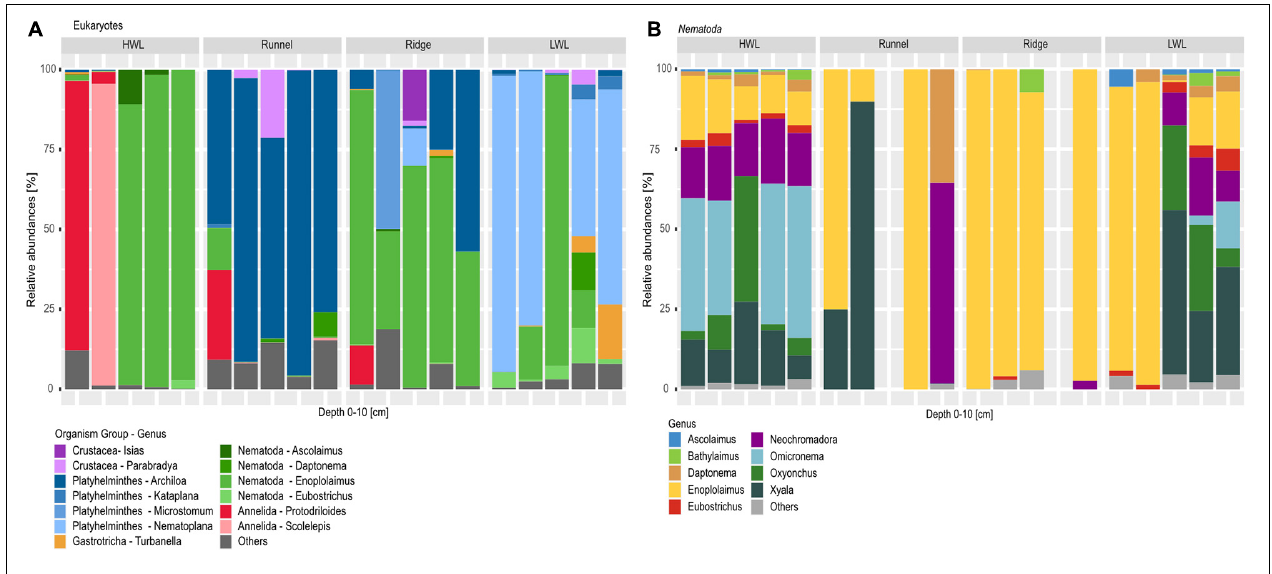
FIGURE 5 | Barplots of eukaryotic communities along the transect depicted on phylum and genus level. (A) Shows total meiofauna diversity, while (B) zooms into nematode diversity, due to their high relative abundances within the dataset and during morphological investigation. Taxa below the abundance threshold were summarized as “others.” One replicate from the runneland Ridge were excluded from the nematode libraries analyses due to low numbers of